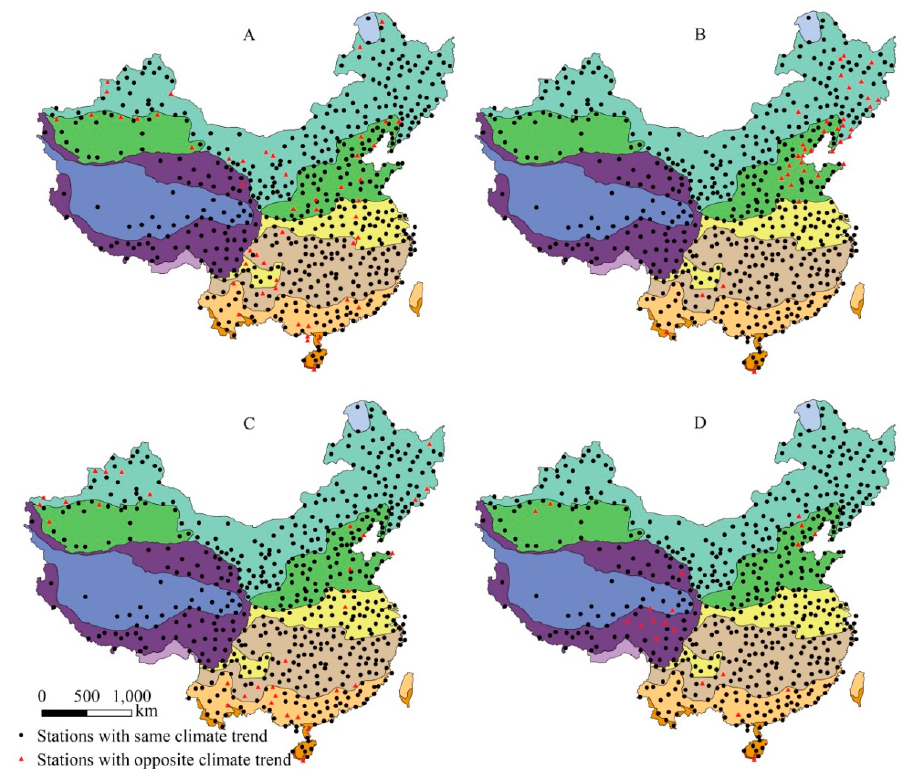
Figure 7. Climate trend of monthly mean temperature for January ( A ), April ( B ), July ( C ) and October ( D ).